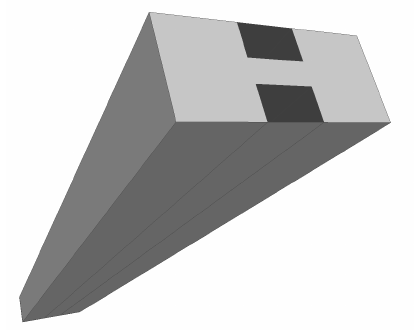
Figure 9. A topological manifold that contains non-obvious ge- ometric intersections. The bottom of the polyhedron, seemingly composed of three rectangular faces, actually has only two rect- angular faces that overlap along the middle third. The top of the polyhedron (not visible) has the same problem. Typical valida- tion tests commonly return that such a shape is